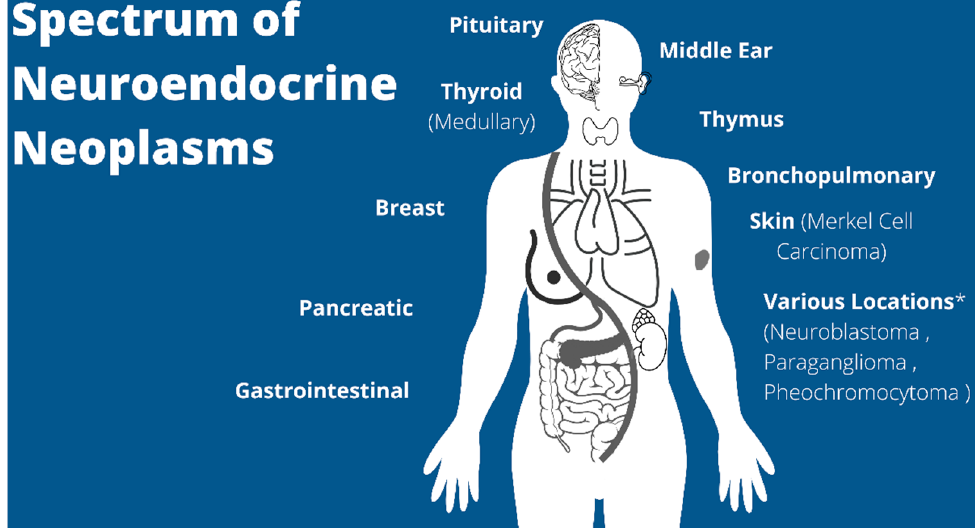
Figure 1. Illustration of some of the common and less common neuroendocrine neoplasms encoun- tered in the pediatric and adult populations (* most commonly originate from the adrenal glands; paragangliomas are extra ‐ adrenal).